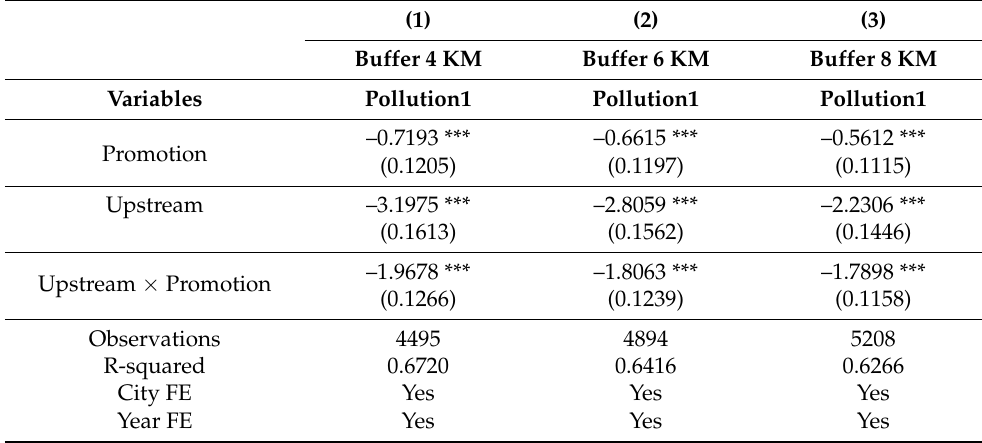
Table A3. Effects of promotion under different buffer distances.